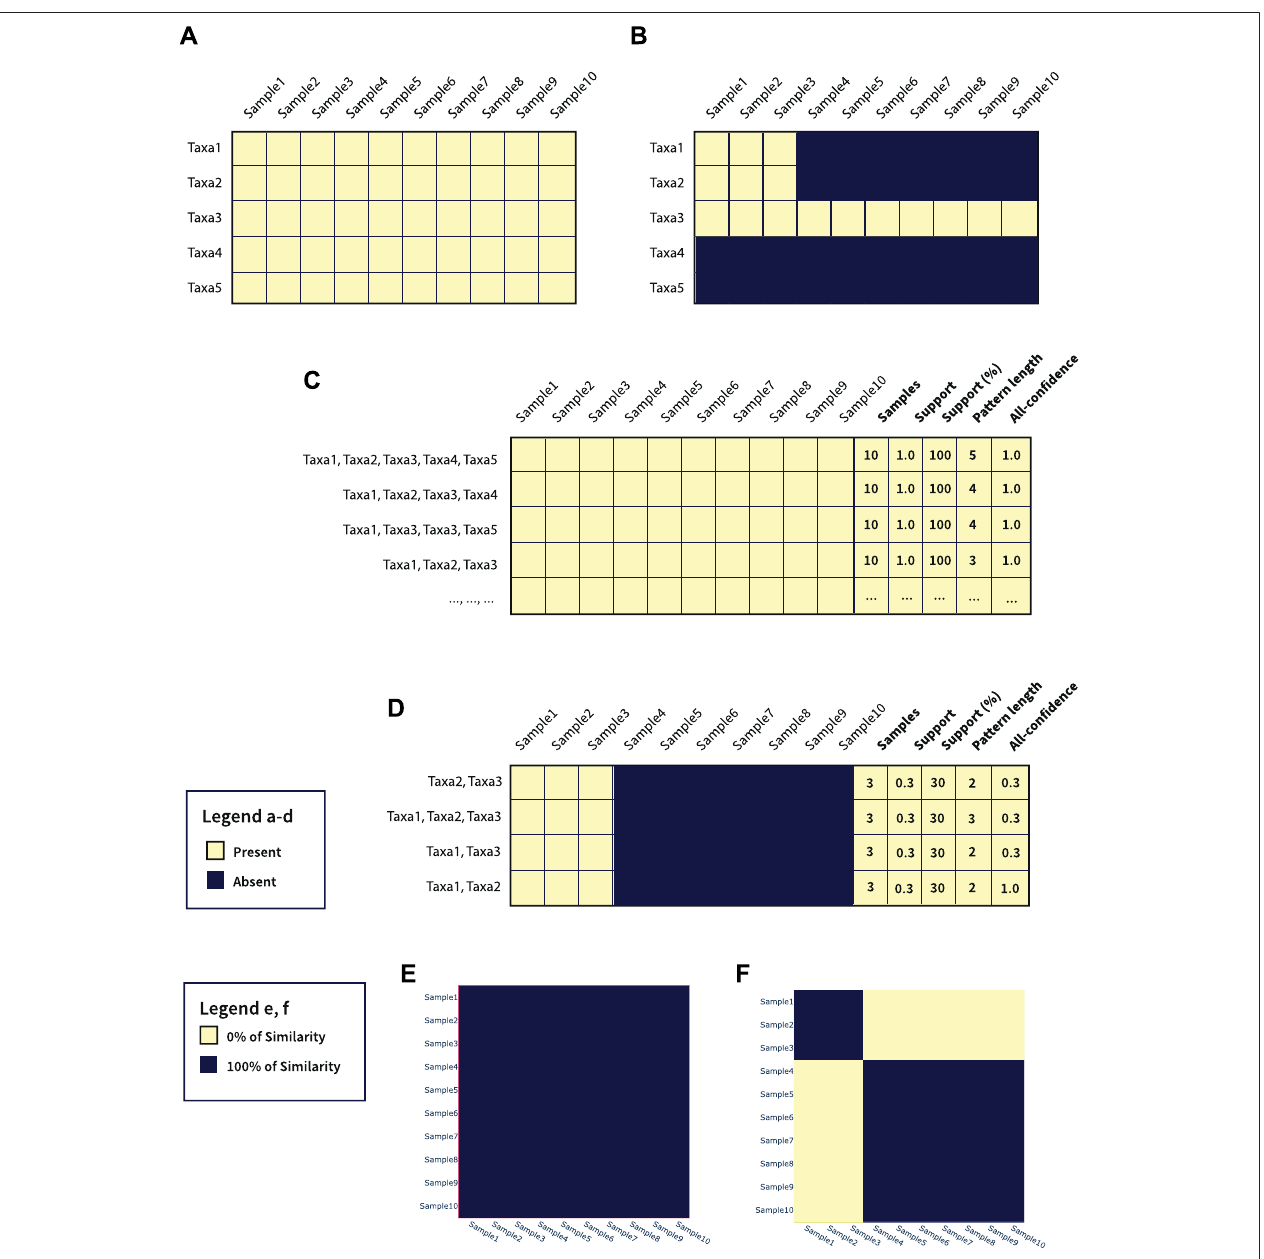
FIGURE 3 | (A) Graphical representation of Table 1; (B) Graphical representation of Table 2; (C) Pattern table generated from Table 1; (D) Pattern table generated from Table 2; (E) Jaccard heatmap plot of Table 1; (F) Jaccard heatmap plot of Table